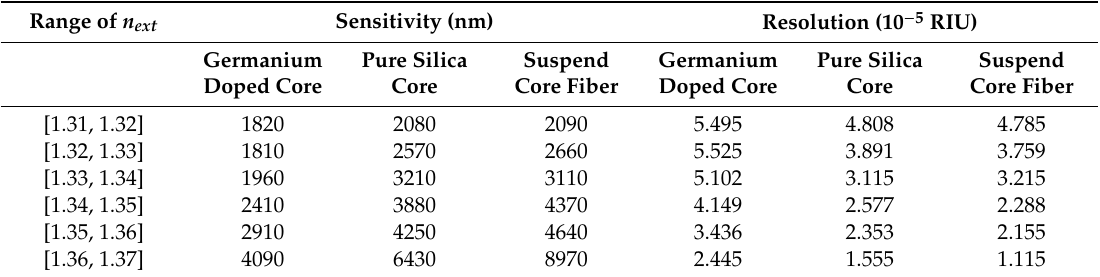
Table 1. Sensitivity, resolution for the three refractive index optical fiber sensing configurations. Range of n